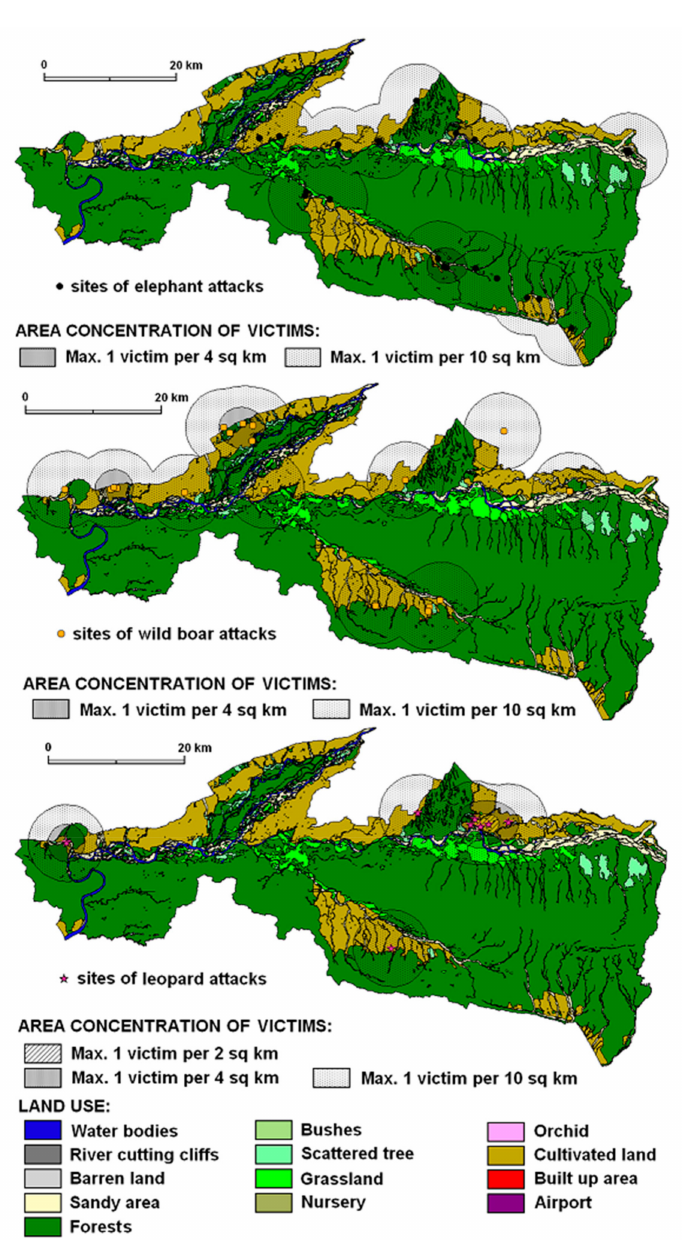
Figure 5. Density areas of recorded attacking animals (elephant, wild boar, and leopard) within di ff erent land use